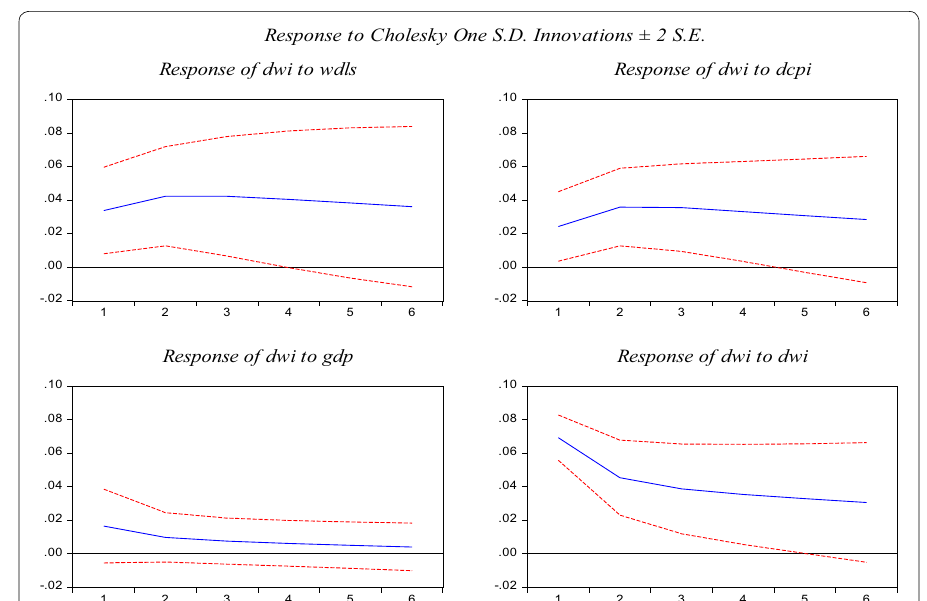
Fig. 6 Results of impulse response functions. Note The optimal lag order is selected as 1 out of 4 according to Schwarz Criteria. Chosen forecast periods: 6 and response standard errors; Monte Carlo. d stands for